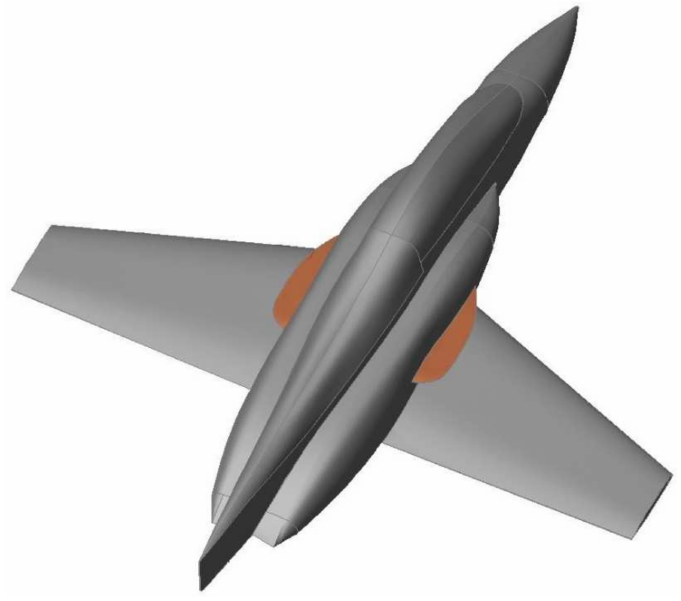
Figure 4. PVG, a powerful vortex generator.